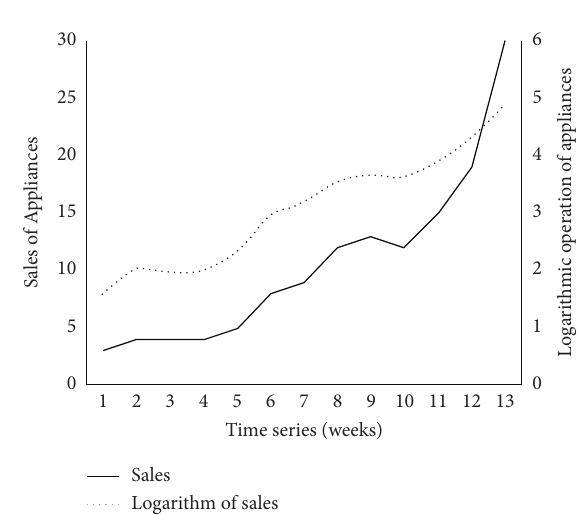
Figure 1: Example of domestic appliance